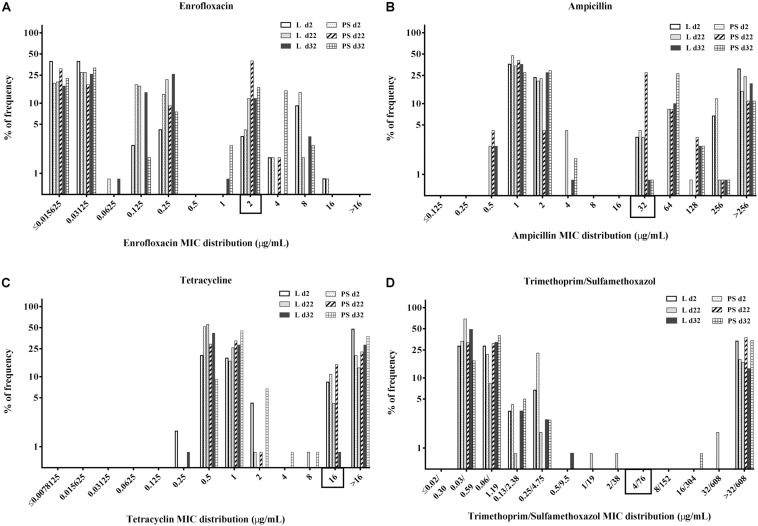
Percentage of frequency of minimum inhibitory concentration (MIC) distribution of enrofloxacin (A), ampicillin (B), tetracycline (C), and trimethoprim/sulfamethoxazole (D) in commensal E. coli isolates from excreta samples (N = 720; per group d2: n = 120, d22: n = 120, d32: n = 120). Rectangle on the x-axis: Categorisation by using CLSI breakpoints for Enterobacteriaceae, enrofloxacin (ENR) ≥ 2 μg/mL, ampicillin (AMP) ≥ 32 μg/mL, tetracycline (TET) ≥ 16 μg/mL and trimethoprim/sulfamethoxazole (SXT) ≥ 4/76 μg/mL. Flooring type: Litter (L) = entire floor stable covered with litter (wood shavings); Partial-slats (PS) = floor stable with litter and one-quarter slatted flooring.